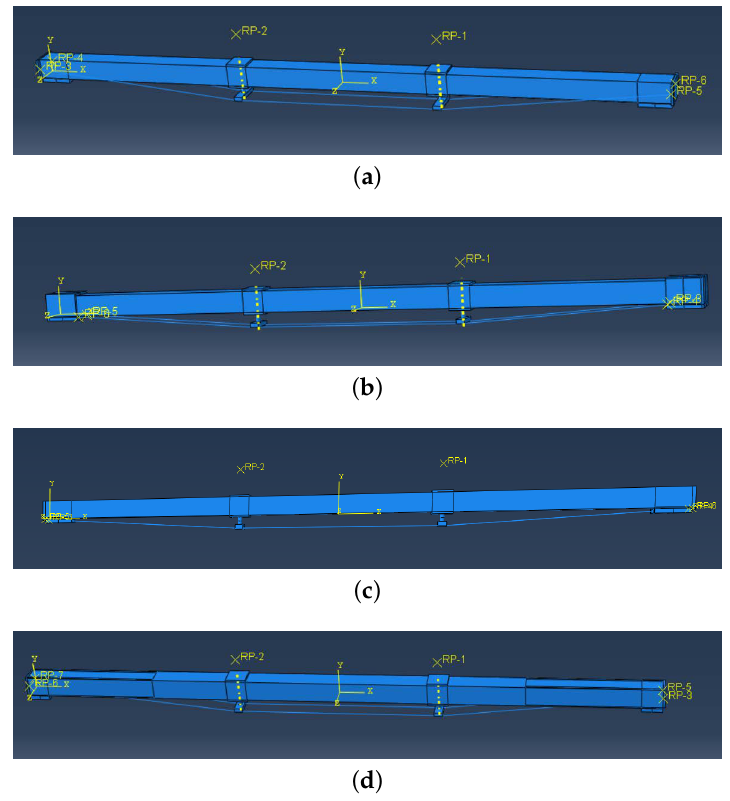
Figure 8. Four prestressed beams models. ( a ) mode I: external anchorage device, ( b ) mode II: boot anchorage device, ( c ) mode III: under beam anchorage device and ( d ) mode IV: slotted anchorage